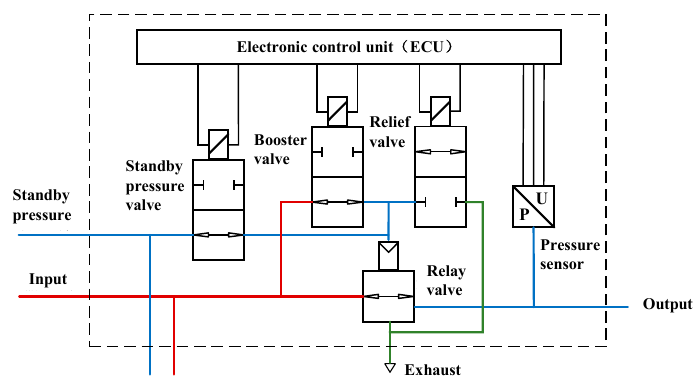
Figure 3. Schematic diagram of BBW pneumatic valves based on EPV.